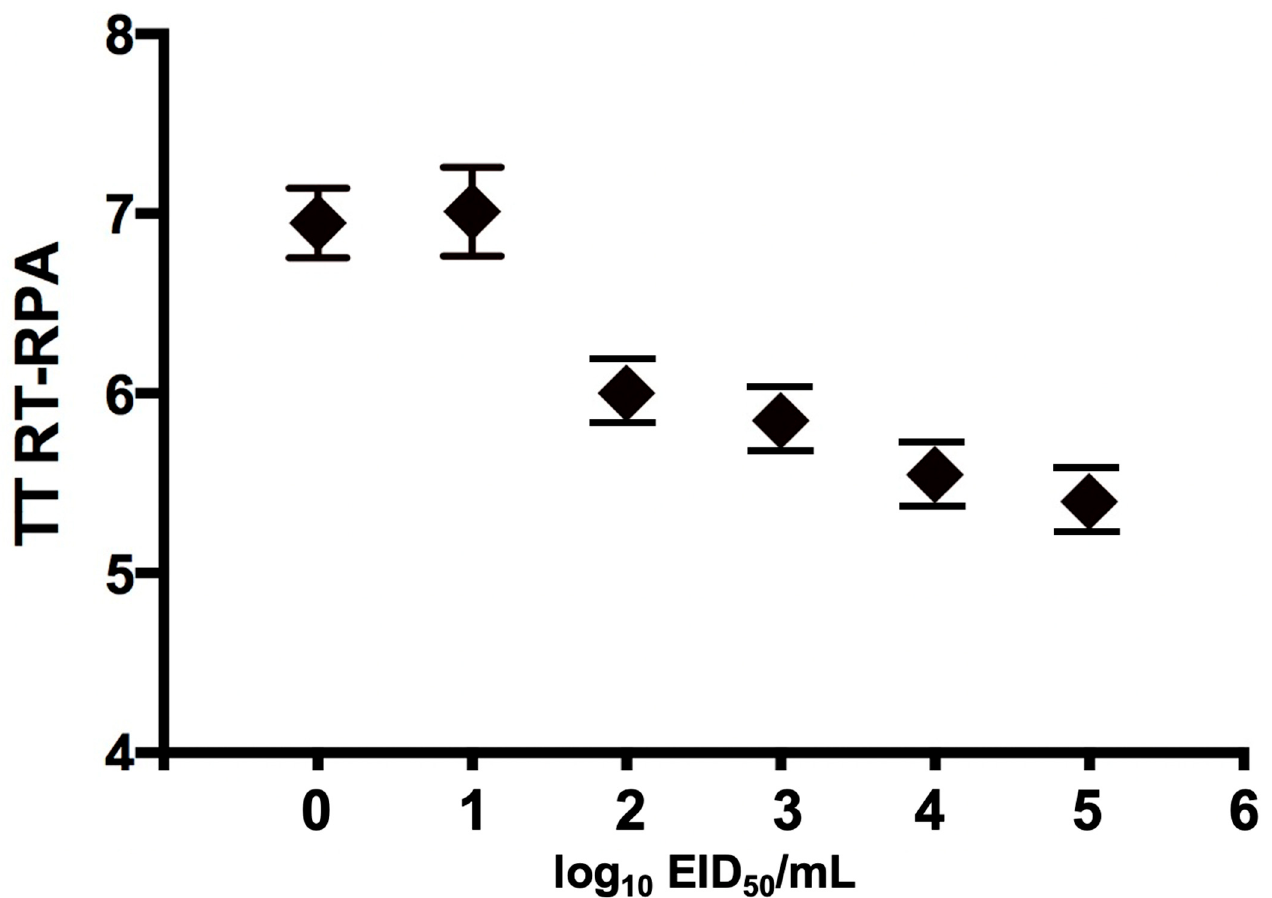
Figure 2. Semi logarithmic regression of the data collected from eight H9 RT-RPA test runs on the viral RNA standard using PRISM Software. H9 RT-RPA results were obtained in 5–8 min. In the H9 RT-RPA assay, 10 0 EID 50 /mL were detected in 8 out of 8 RT-RPA runs. Rhomboid represents the mean values, and lines are the error bars.